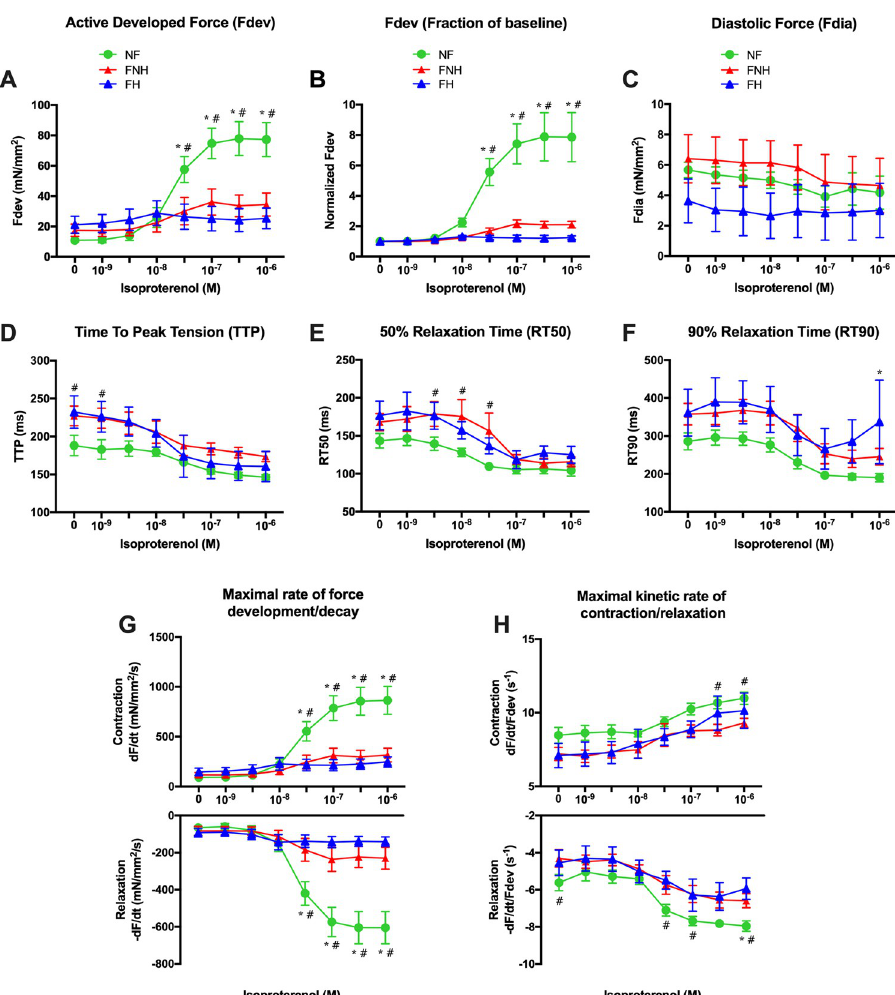
Fig 4. β -adrenergic stimulation in NF trabeculae ( n = 9) vs. failing trabeculae with no hypothyroidism (FNH; n = 9) and failing trabeculae with hypothyroidism (FH; n = 4). (A) F dev was increased in NF trabeculae upon addition of isoproterenol in a concentration dependent manner and was significantly greater than the increase in both failing groups. (B) Same data as panel A, plotted to each muscle’s force at baseline to allow equal weight of each muscle in the statistical analysis. (C) F dia slightly decreased in NF and both failing groups over the concentration range with no significant difference between the three groups. (D) TTP shortened almost similarly in all three groups upon increasing isoproterenol concentration. (E) RT50 slightly decreased as concentration increased from 1 nM to 1 μ M in all three groups. (F) RT90 was not significantly different between the three groups over the concentration range. (G) +dF/dt and -dF/dt were sped up in NF and failing groups as isoproterenol concentration increased and were significantly faster in NF group compared to both failing groups at the concentration range of 30 nM—1 μ M. (H) NF myocardium showed faster +dF/dt/F dev and -dF/dt/F dev throughout the concentration-response protocol compared to both failing groups with significantly faster +dF/dt/F dev at 0.3 μ M and 1 μ M and significantly faster -dF/dt/F dev at 30 nM, 0.1 μ M and 1 μ M vs. FNH myocardium. Data are depicted as means ± SEM; A two-way repeated measures ANOVA followed by Tukey’s post hoc test for multiple comparisons; � indicates P < 0.05 significant difference between NF and FH groups; # indicates P < 0.05 significant difference between NF and FNH groups at corresponding isoproterenol concentration. Abbreviations as in Fig